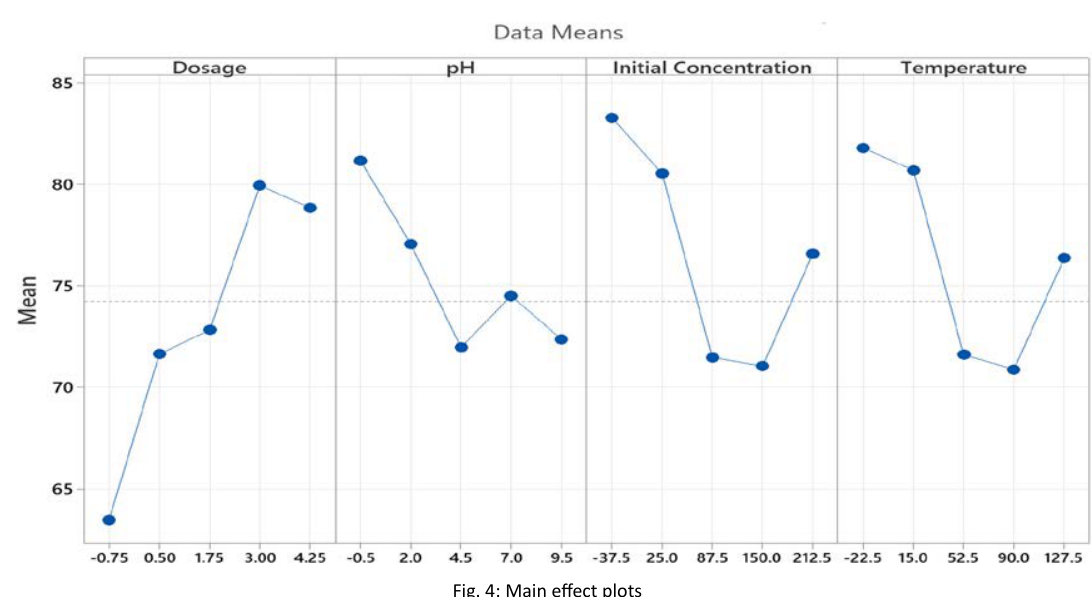
Fig. 3: Residual plots for removal efficiency